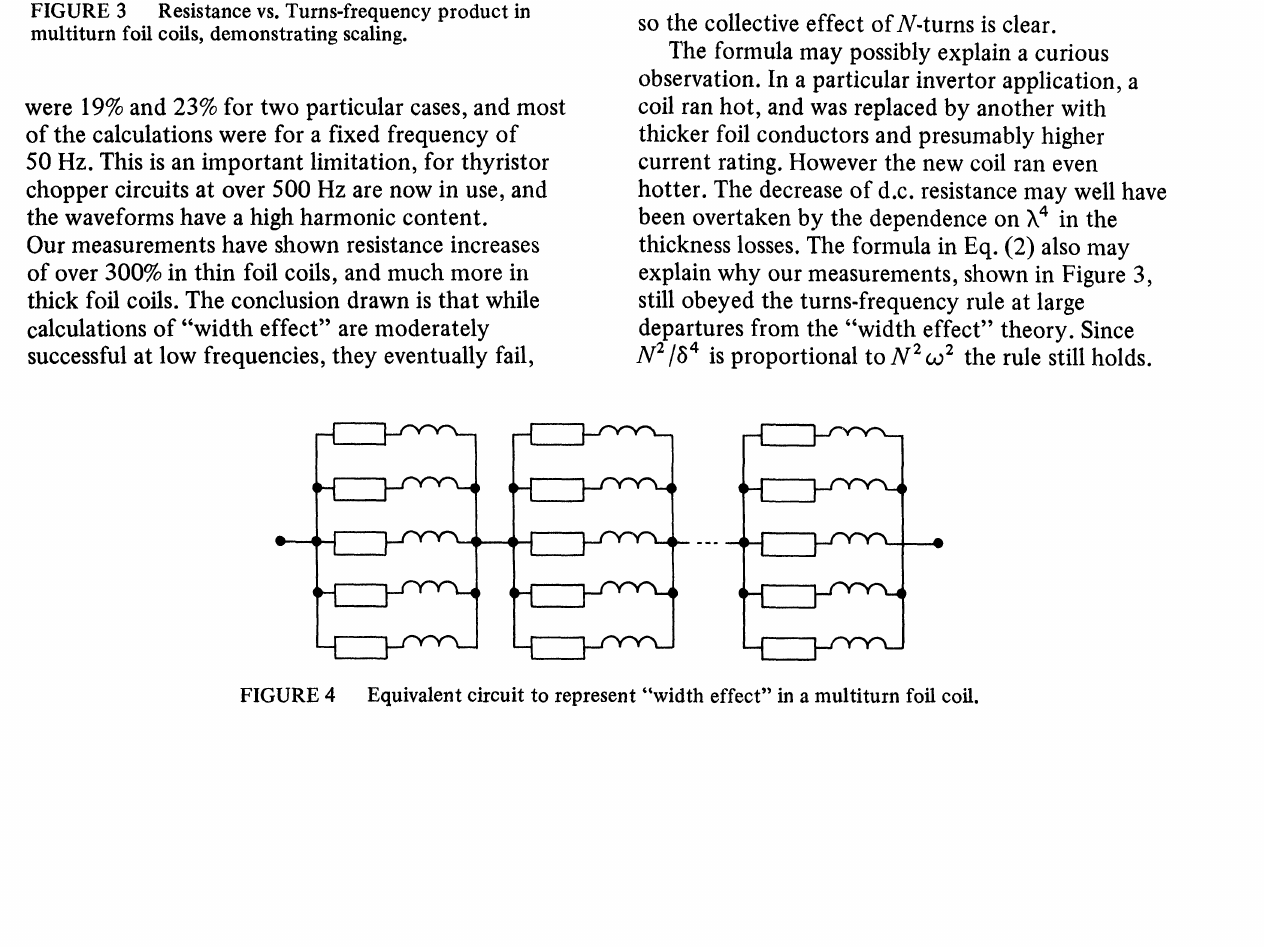
Equivalent circuit to represent "width effect" in a multiturn foil